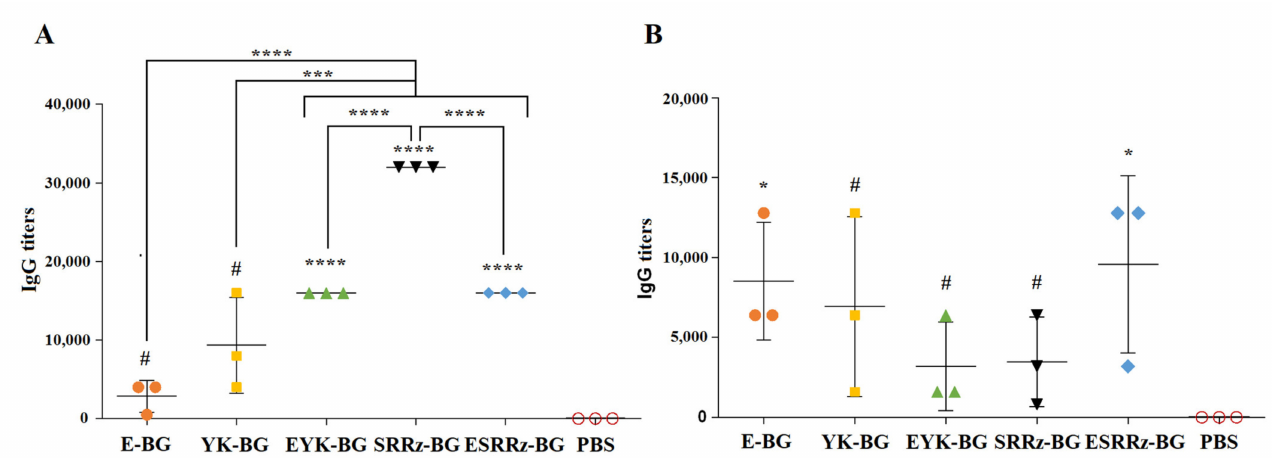
Figure 4. Antibody response in sera of guinea pigs ( A ) and mice ( B ) immunized s.c. with E-BG, EYK-BG, YK-BG, SRRz-BG, ESRRz-BG, and PBS, respectively at week 4 post administration. 100 µ L of Y. pestis BGs were coated as antigen, the goat anti-mouse IgG-HRP or goat anti-guinea pig IgG-HRP was used as detection antibody. # — p > 0.05; *— p < 0.05; ***— p < 0.001; ****— p < 0.0001.